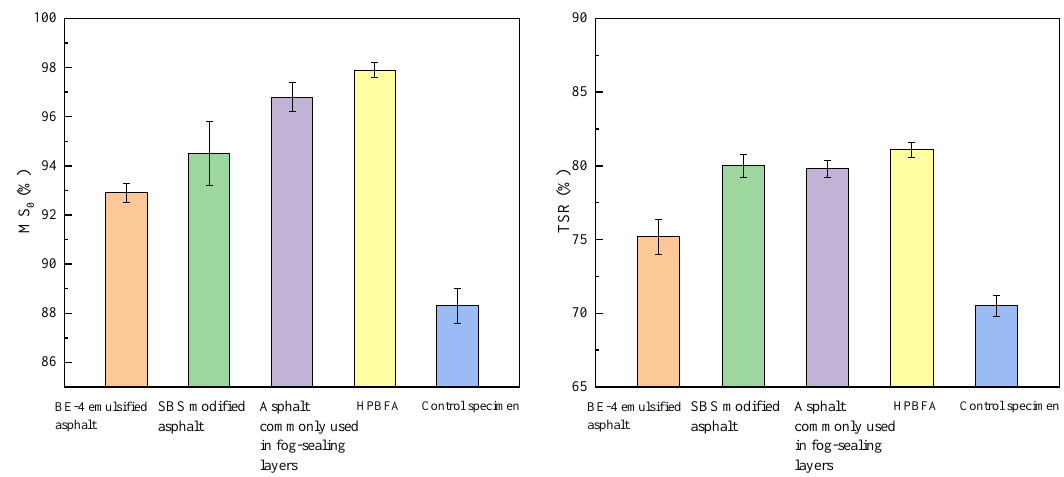
Figure 13. Results of water stability tests on different types of fog-sealing adhesive materials.